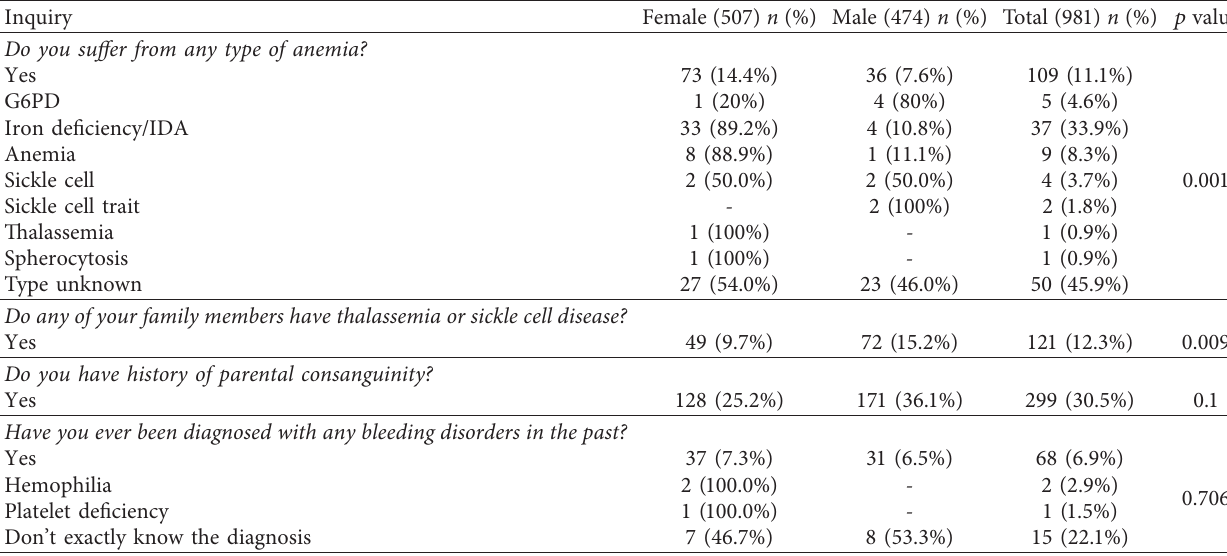
Table 1: Responses to the survey questionnaire ( n �